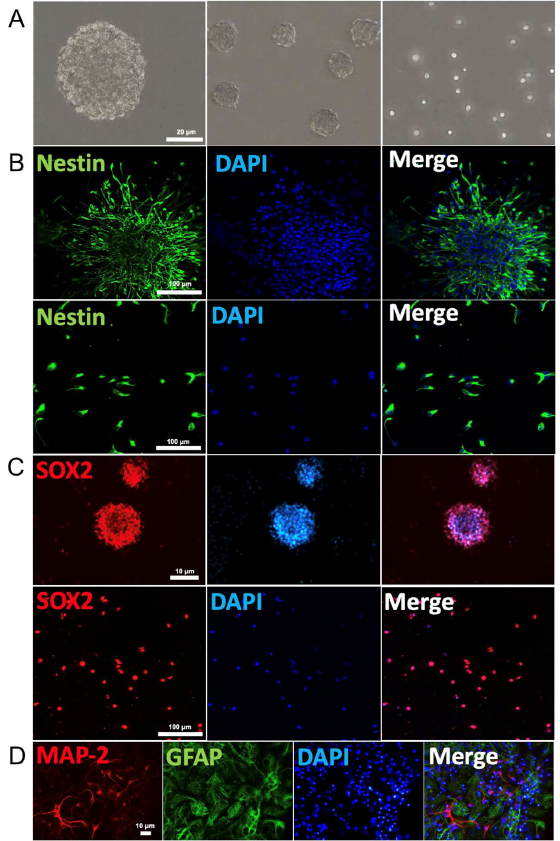
Figure 1. Neural stem cell identification: ( A ) Neurospheres and free single cells representing typical morphological feature of NSCs. ( B ) Immunofluorescence of neurospheres (top row) and single cells (bottom row) show expression of the NSC markers nestin (green). Cell nuclei were counterstained with DAPI (blue). ( C ) Immunofluorescence of neurospheres (top row) and single cells (bottom row) for SOX2 (red) expression and nuclei counterstained with DAPI (blue). ( D ) Immunostaining identification of the primary mouse cortex NSCs. Neural dendrites and axons were identified by anti- MAP-2 (red) and astrocytes by GFAP (green). The nuclei of all cells were identified by DAPI (blue).